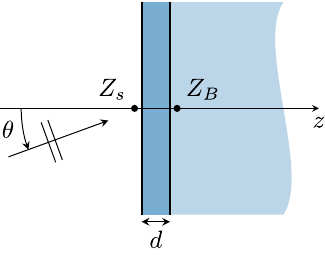
Figure 1. Con fi guration under study. The backing is known through its surface impedance Z B , the system is impinged by a plane wave propagating at an angle h from the normal to the